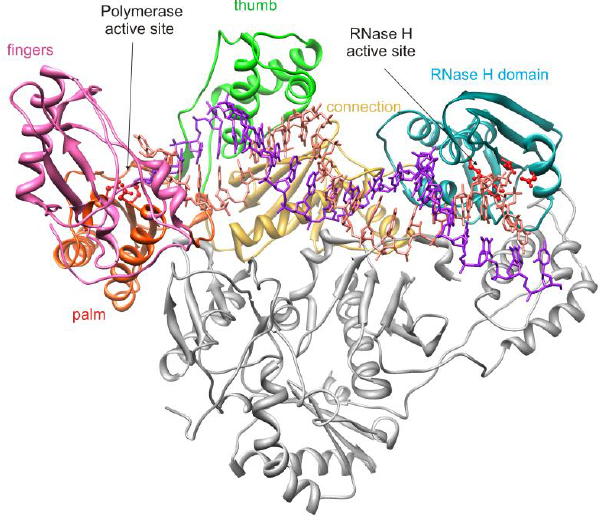
Figure 1. Structure of HIV-1 p66/p51 heterodimeric reverse transcriptase in complex with nucleic acid. The subdomains of the p66 subunit are depicted in different colors; the p51 subunit is depicted in gray. The red ball and stick residues in the RNase H domain denote the active site carboxylate amino acids. The figure is derived from PDB file 1RTD and was drawn using UCSF Chimera software